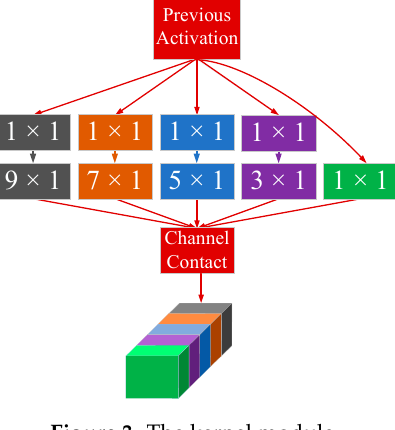
Figure 3. The kernel module.